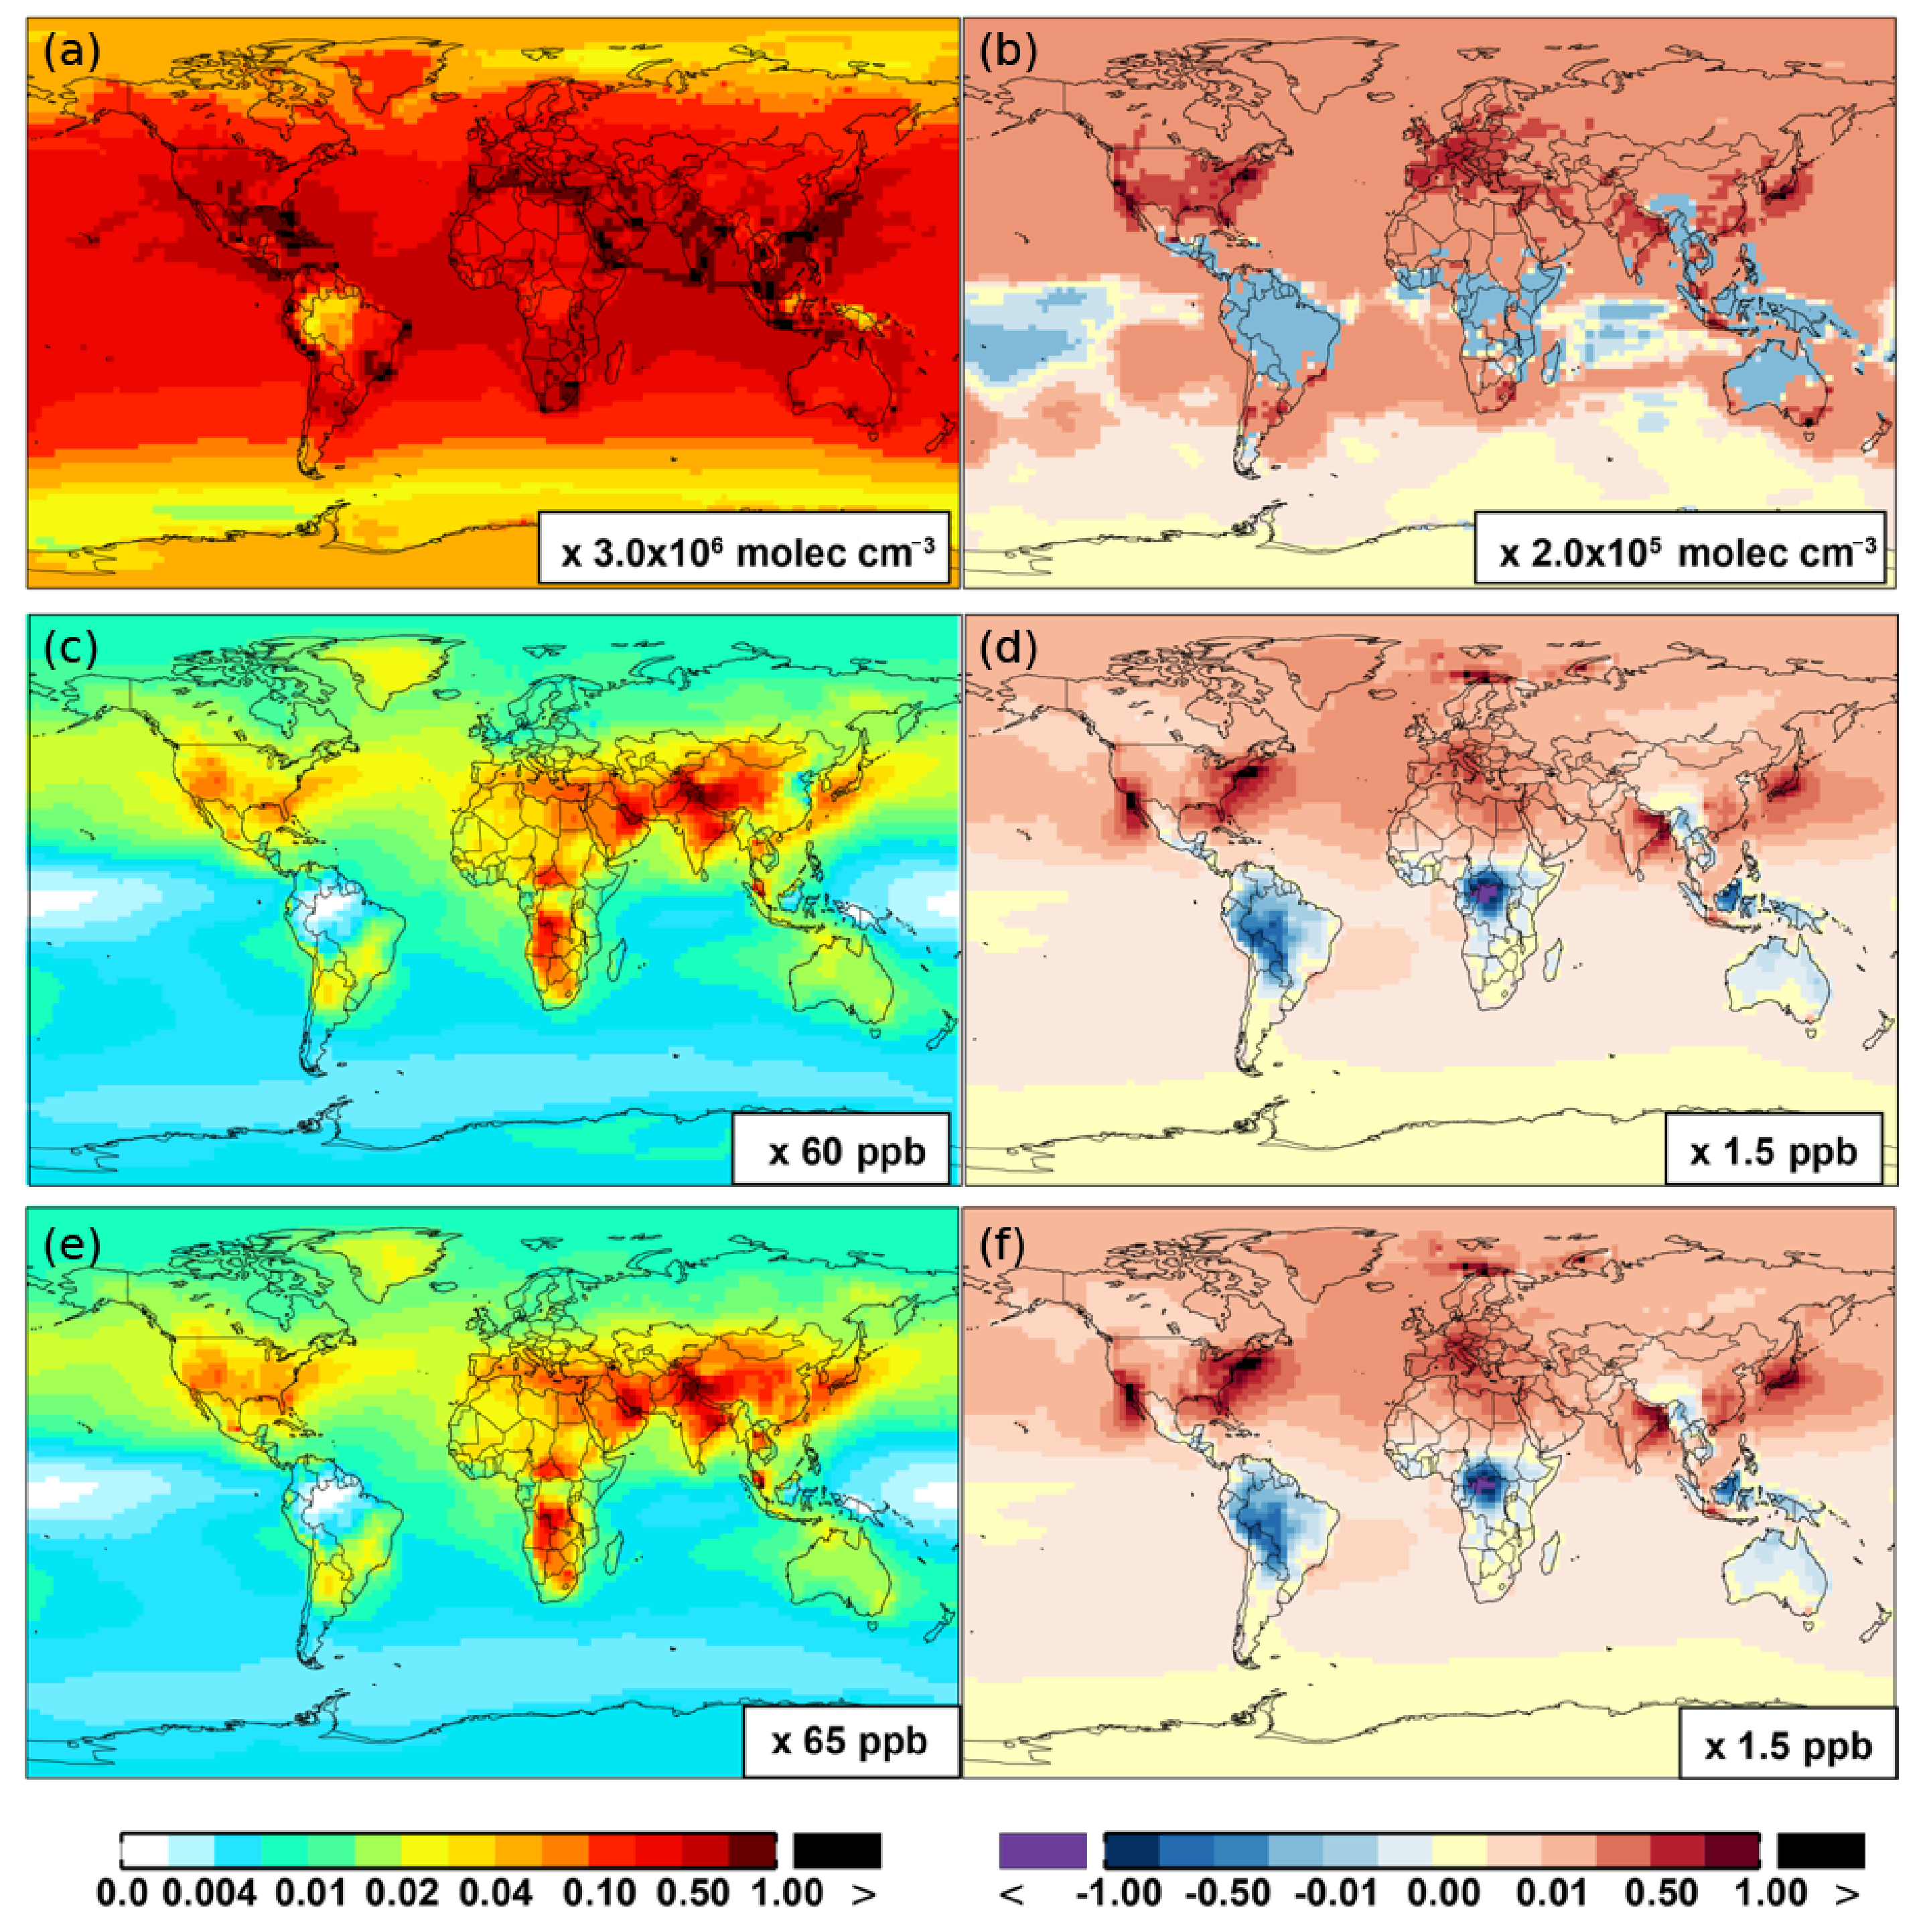
Same as Fig. 6 but for OH (a, b), O3
(c, d), and Ox
(e, f).